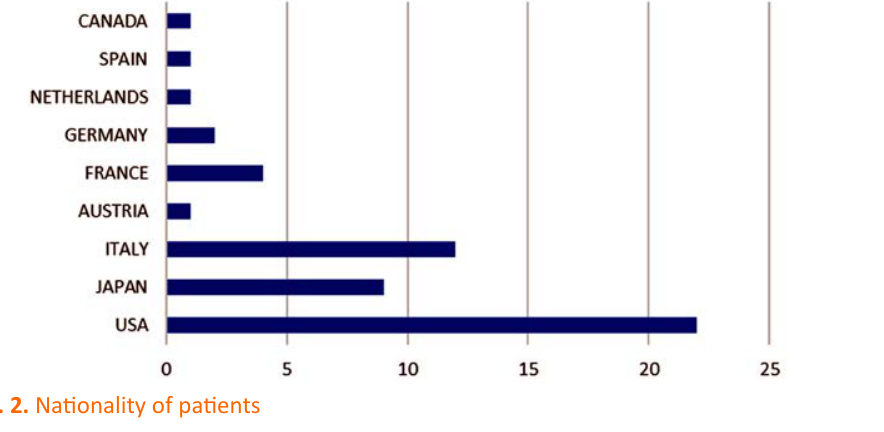
Fig. 2. Nationality of